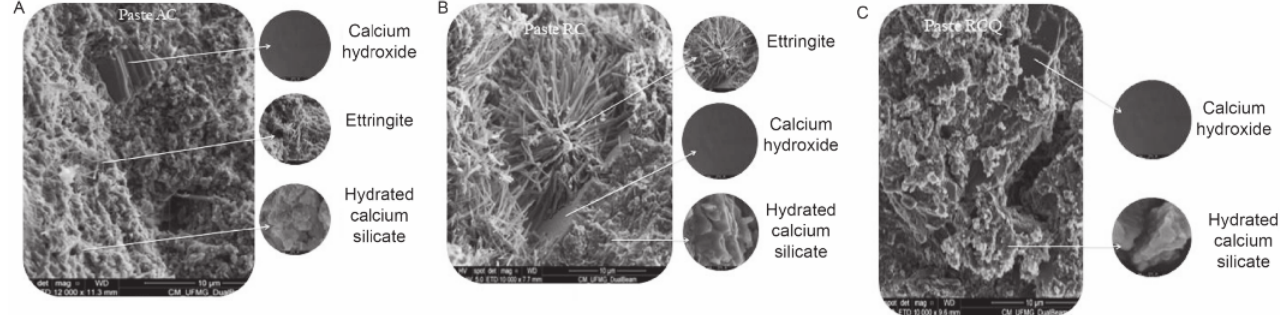
Characterization of paste microstructures: (A) Paste produced with anhydrous Portland cement (AC), (B) paste produced with recycled cement (RC), (C) paste produced with recycled cement and 15% replacement of the recycled cement by sand powder